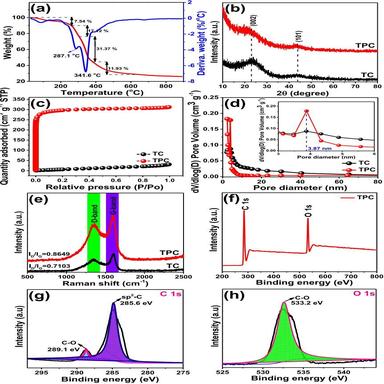
(a) TGA spectrum of APF biomass; (b) XRD patterns, (c) Raman spectra, (d) nitrogen adsorption-desorption isotherms and (e) pore-size distributions of the TC and TPC samples; (f-h) XPS spectra of TPC: (f) full survey, (g) C 1s and (h) O 1s.